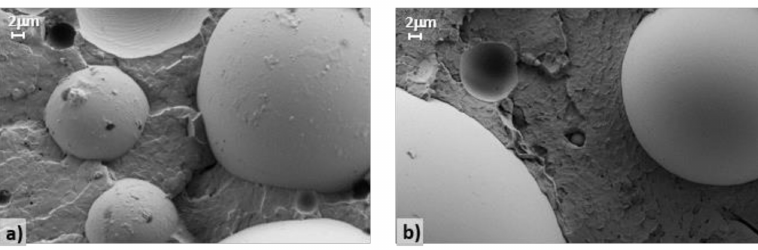
Figure 3. SEM images of samples ( a ) 0, ( b ) 1, and ( c ) 2.